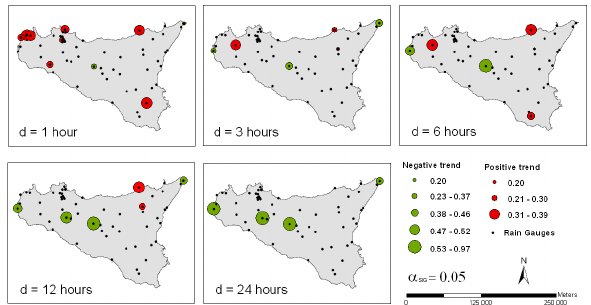
Figure 4. Spatial distribution of the analyzed raingauges and trend sign and magnitude of 2 Fig. 4. Spatial distribution of the analyzed rain gauges and trend annual maxima time series exhibiting a significant trend for the five rainfall durations. 3 sign and magnitude of annual maxima time series exhibiting a sig- nificant trend for the five rainfall